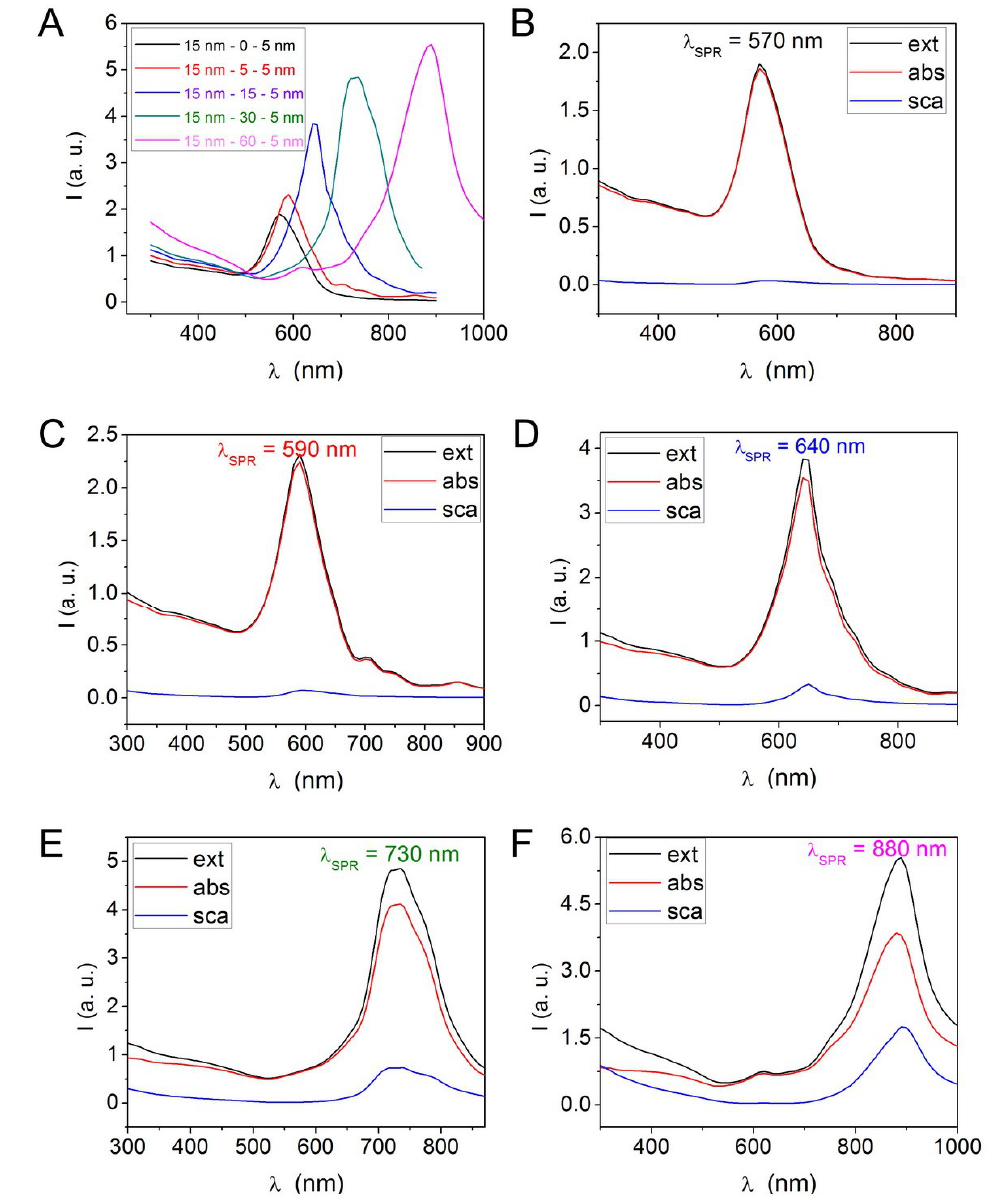
Figure 5. DDA simulation results I ( λ ), referring to the wavelength-dependence of extinction (ext), absorption (abs), and scattering (sca). ( A ) The extinction curves of UCNP@mSiO 2 -Au NPs with different silica shell thickness D . The extinction (absorbance and scattering) curves of UCNP@mSiO 2 -Au NPs with silica shell thickness D of ( B ) 0 nm, ( C ) 5 nm, ( D ) 15 nm, ( E ) 30 nm, and ( F ) 60 nm.